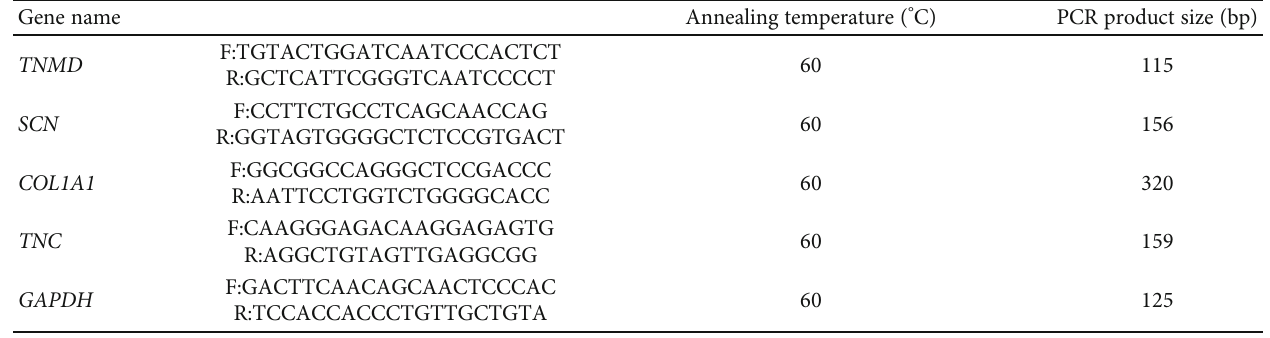
Table 1: Primers used in qPCR analysis.